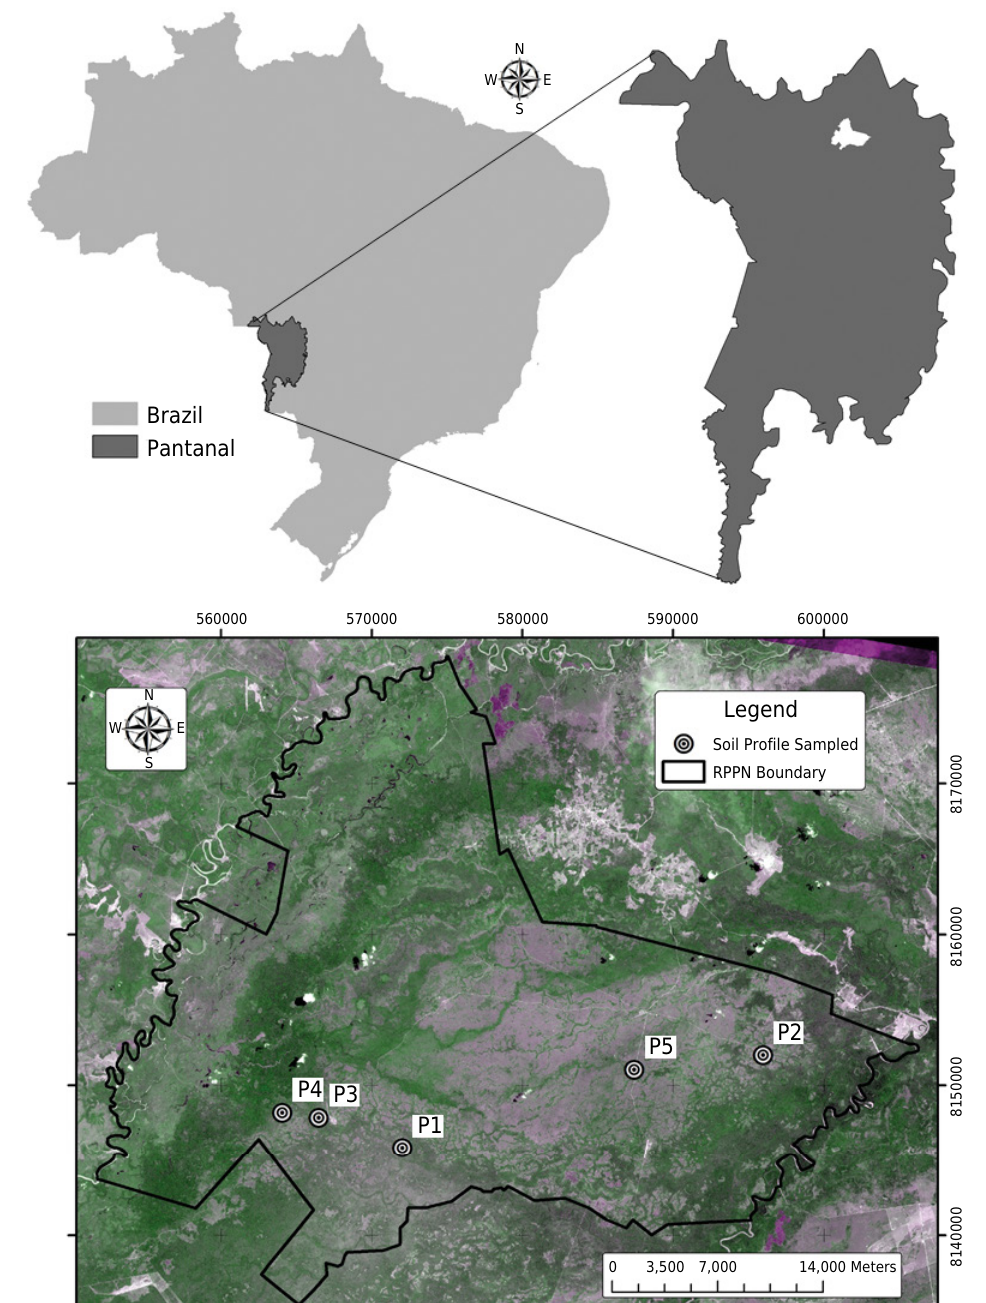
Figure 1. Location of the Pantanal region within Brazilian territory and the RPNN SESC Pantanal (white area) within the Pantanal. Distribution of the five profiles (P1, P2, P3, P4, and P5) within the SESC Pantanal